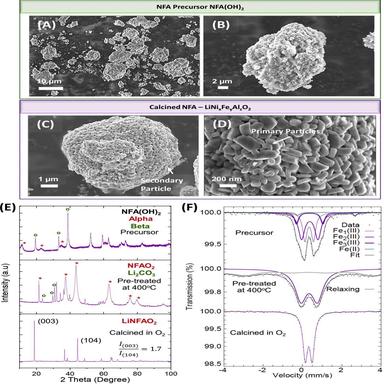
Morphological and crystallographic assessment of the NFA powders: (A–D) SEM micrographs of the precursor and the calcined final product (E) X-Ray diffractograms and (F) Mossbauer € spectra of the precursor, pretreated intermediate material and the calcined final product.